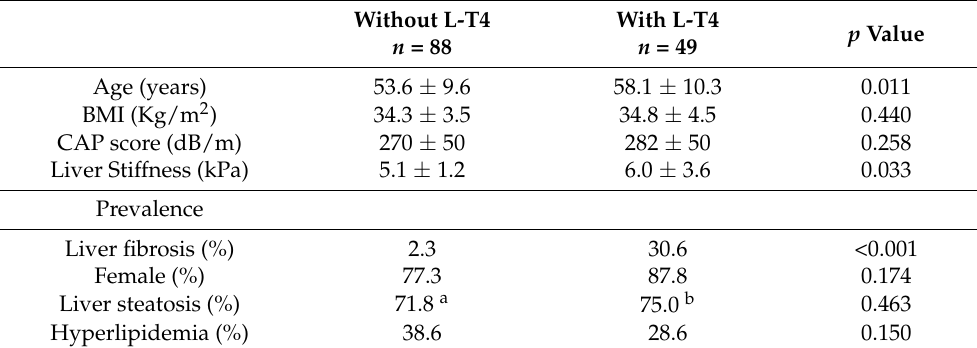
Table 1. Mean +/ − SD Participants’ clinical characteristics according to L-T4 use.